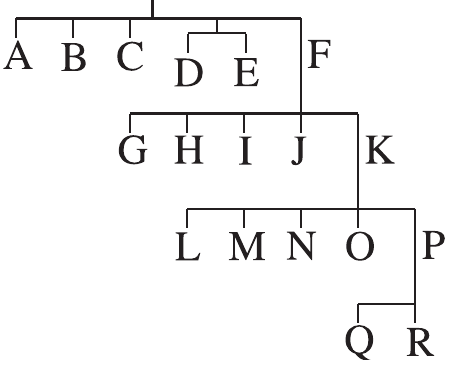
Figure S1 NRY haplogroup SNP tree used to type each sample in our ground-truth training set. Found at: doi:10.1371/journal.pcbi.1000093.s001 (0.02 MB EPS) Figure S2 Accuracy of each classifier per haplogroup of predicting the public STR data set using the 9-locus subset of our ground-truth data as training. The lower panel shows the frequency of samples among haplogroups in the public data set. Figure S3 Tandem classification accuracy and agreement per haplogroup on the public data set using the 9-locus subset of our ground-truth data as training. Found at: doi:10.1371/journal.pcbi.1000093.s003 (0.03 MB EPS) Figure S4 Screen capture of the STR score review console from the laboratory information management system. The red dashed box contains STR loci names as headings for the columns of collected loci score data. The pop-up window (in black) show the quality assessment score for a selected sample. The yellow dashed ellipse highlights our software’s haplogroup classification and confidence value for each algorithm in the tandem approach. Found at: doi:10.1371/journal.pcbi.1000093.s004 (0.44 MB EPS)